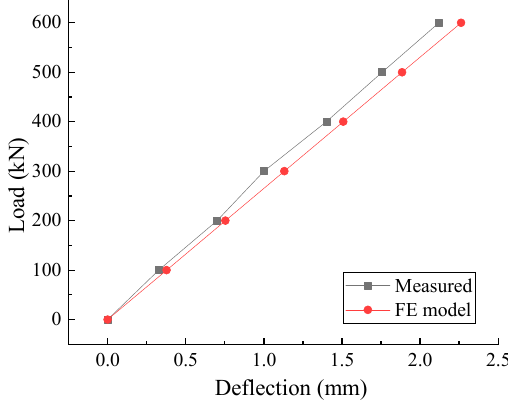
Figure 6. Mid-span load–deflection curve of the beam under static loading.